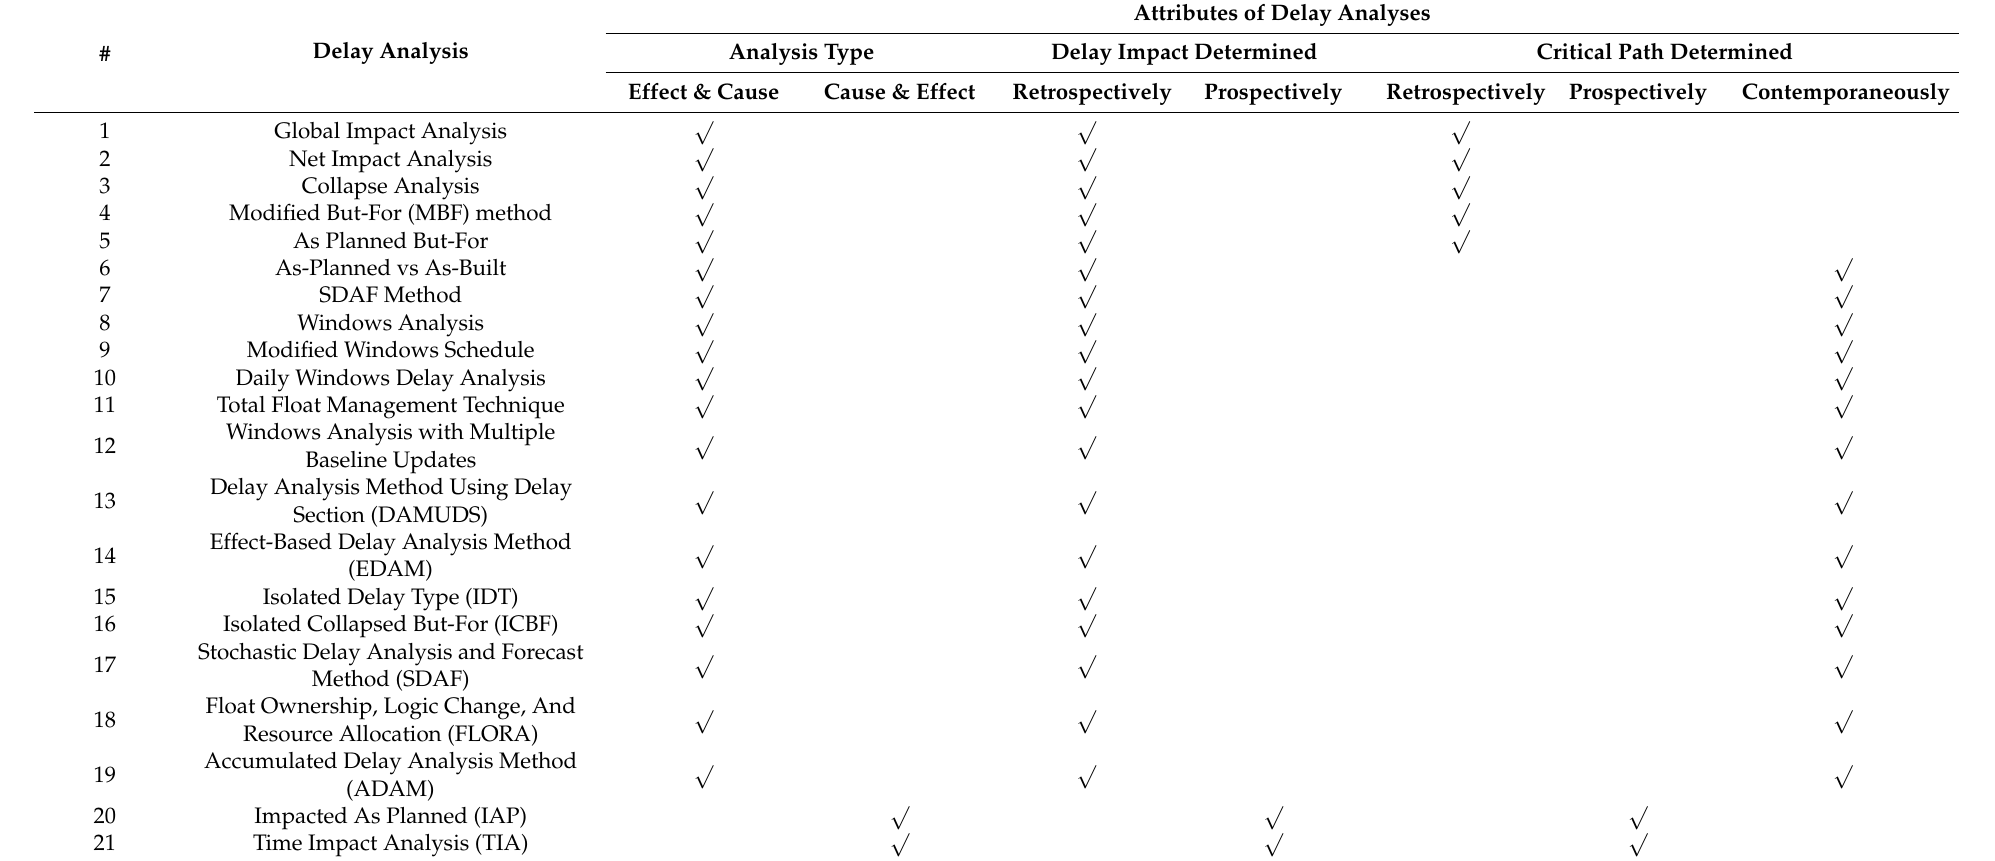
Table 7. Existing Delay Analysis